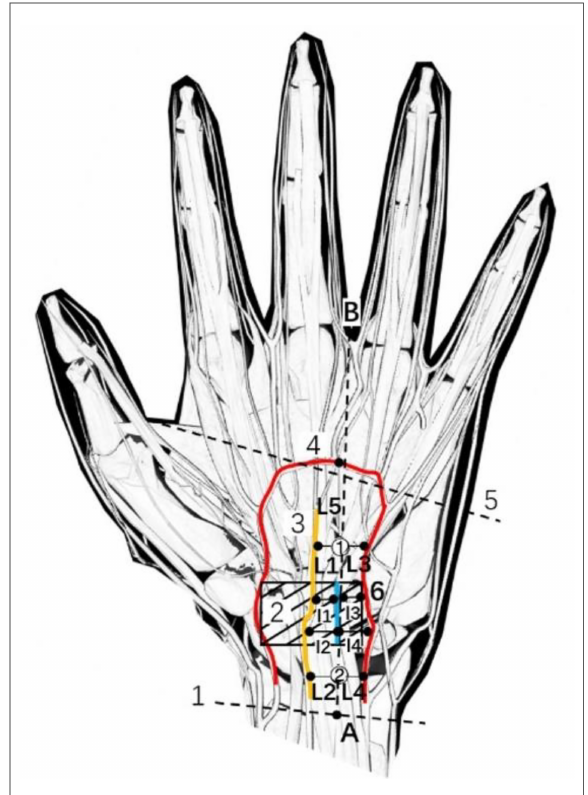
FIGURE 9 Schematic diagram of measurement indicators. 1, Proximal transverse carpal striae; 2, Transverse carpal ligament; 3, Median nerve; 4, Palmar Super fi cial arch; 5, Kaplan line; 6, Ulnar artery; ① , needle entry point 1; ② , needle entry point 2; ( A ) the intersection of the palmar longus tendon with 3 mm lateral to the ulnar side and the transverse stripes of the proximal wrist; ( B ) the intersection of the ring fi nger and the middle fi nger; L1, the shortest lateral distance between needle insertion point 1 and median nerve; l1, the shortest lateral distance between the cutting traces of the acupotomy at needle insertion point 1 and median nerve; L2, the shortest lateral distance between needle insertion point 2 and median nerve; l2, the shortest lateral distance between the cutting traces of the acupotomy at needle insertion point 2 and median nerve; L3, the shortest lateral distance between needle insertion point 1 and ulnar artery; l3, the shortest lateral distance between the cutting traces of the acupotomy at needle insertion point 1 and ulnar artery; L4, the shortest lateral distance between needle insertion point 2 and ulnar artery; l4, the shortest lateral distance between the cutting traces of the acupotomy at needle insertion point 2 and ulnar artery; L5, the shortest lateral distance between needle insertion point 1 and palmar super fi cial arch; l5, the shortest lateral distance between the needle tip at needle insertion point 2 and palmar super fi cial arch.